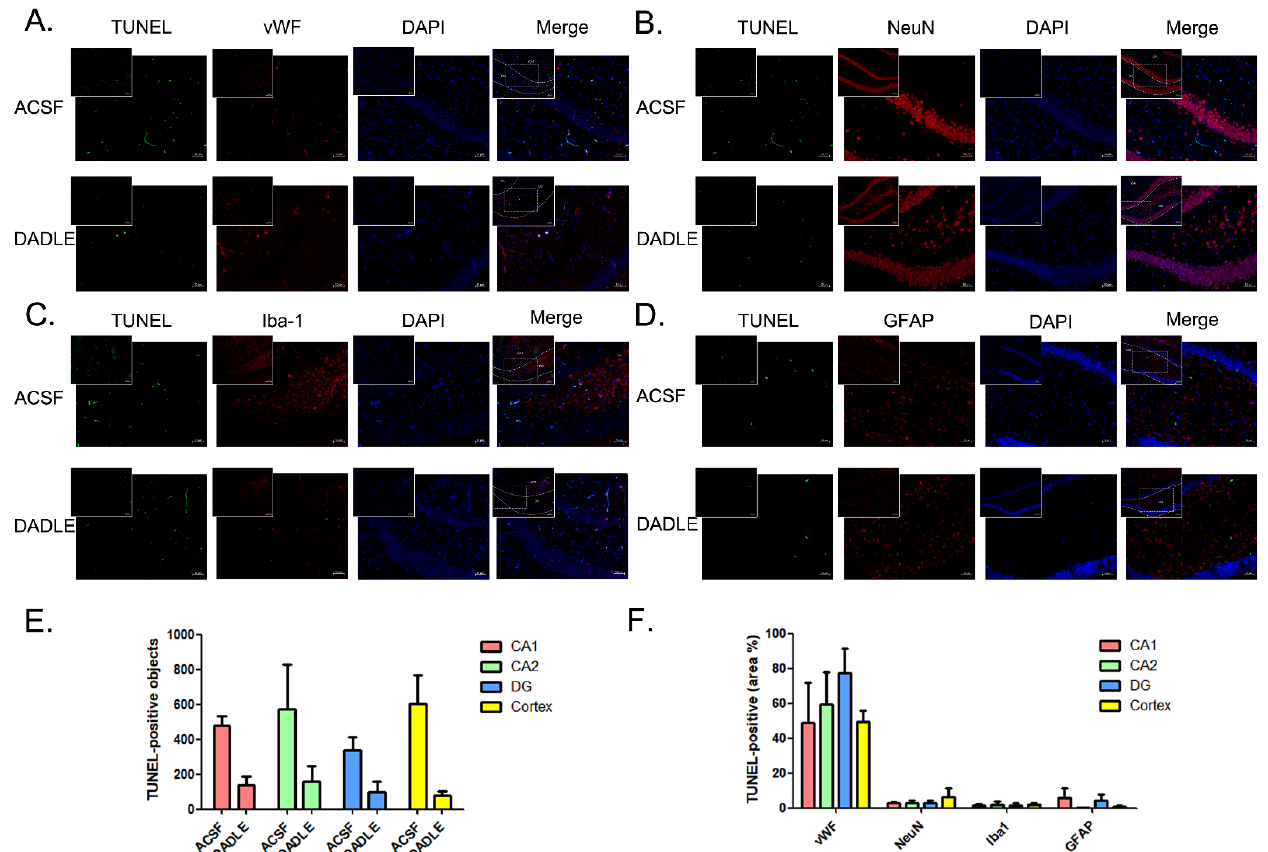
Figure 2. MCAO/R increased cellular apoptosis detected by TUNEL staining in the DG area of the hippocampus which mainly co-localized with vascular endothelial cells, but not neuron, microglia nor astroglia, and DADLE (5 nmol/10 μL) pretreatment decreased endothelial apoptosis at 72 h after surgery. ( A – D ) dUTP nick-end labelling (TUNEL)-positive cells were stained green. Nuclei were stained with DAPI and shown as blue. Red fluorescence signals represented different cellular markers. vWF was considered as the marker of vascular endothelial cells ( A ), NeuN as that of neuron ( B ), Iba-1 as that of microglia ( C ) and GFAP as that of astroglia ( D ). ( E ) Statistical analysis of the TUNEL-positive objects within the CA1, CA2 and DG of the hippocampus or cortex area of ACSF- and DADLE-pretreated group. ( F ) The percentage of TUNEL-positive signals within different brain areas. Bars represent the mean ± S.E.M. Every group contained data from three rats.